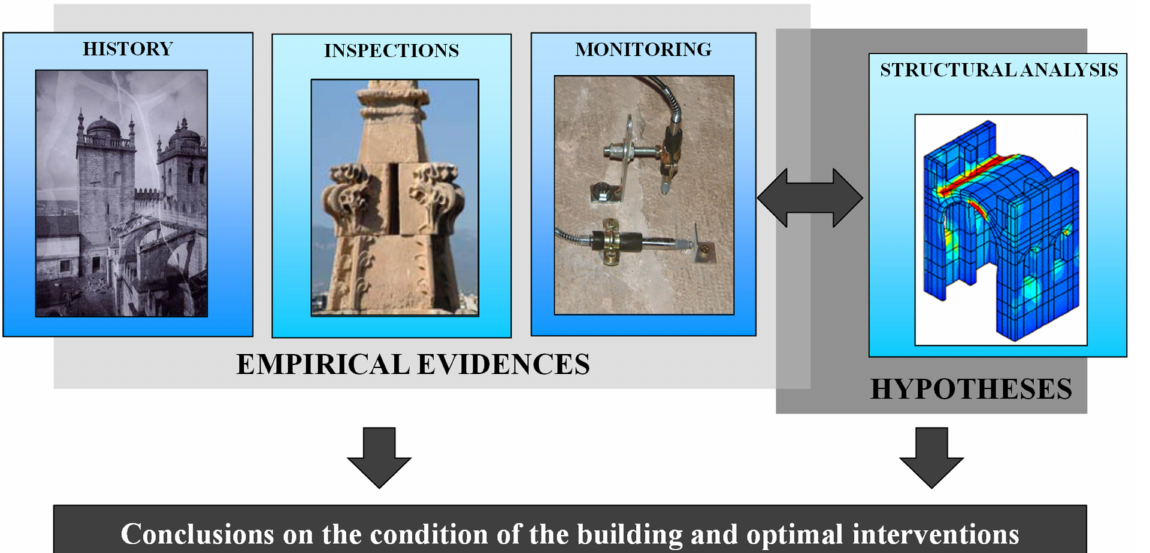
Figure 13. Framework of the scientific approach to the analysis of architectural